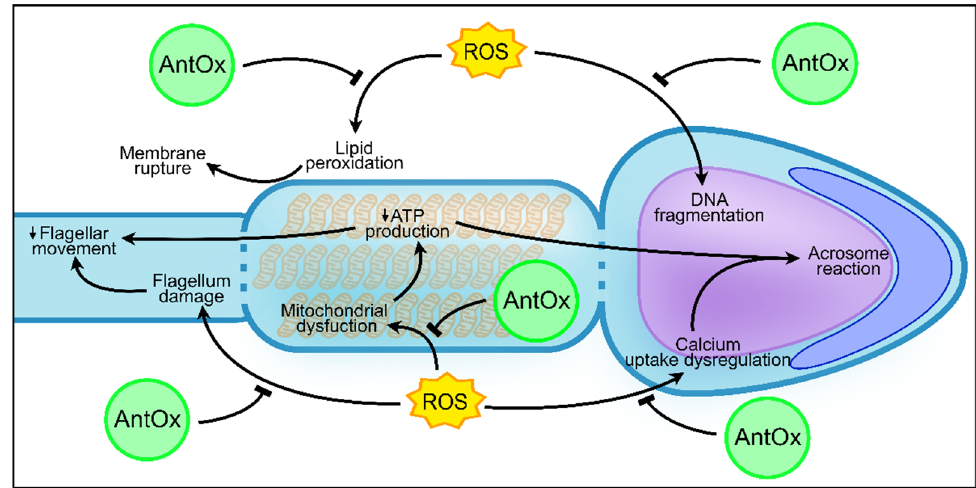
Figure 2. Protective role of antioxidants against oxidative damage in sperm in contact with re- active oxygen species. AntOx—Antioxidants; ROS—Reactive oxygen species; ATP—Adenosine